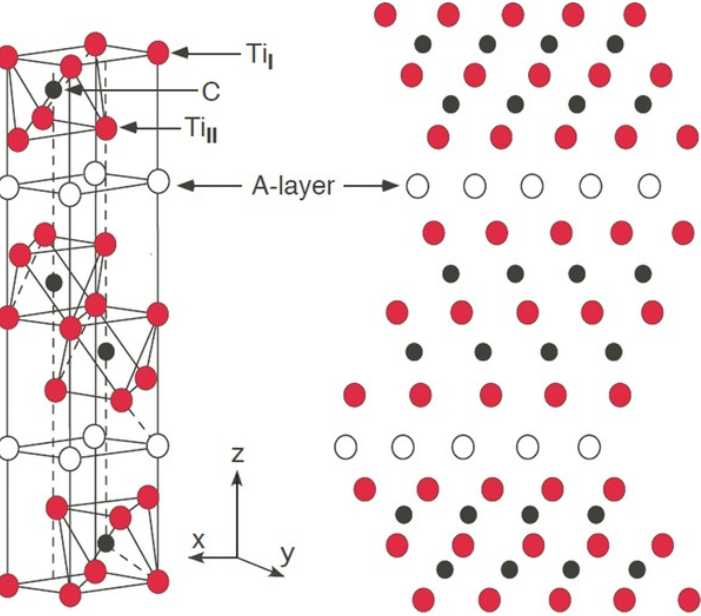
Figure 1. Crystal structure of a 312 MAX phase. Ti atoms occupy two different sites, Ti I and Ti II . A layer of A-group atoms appears after each third Ti layer [33].